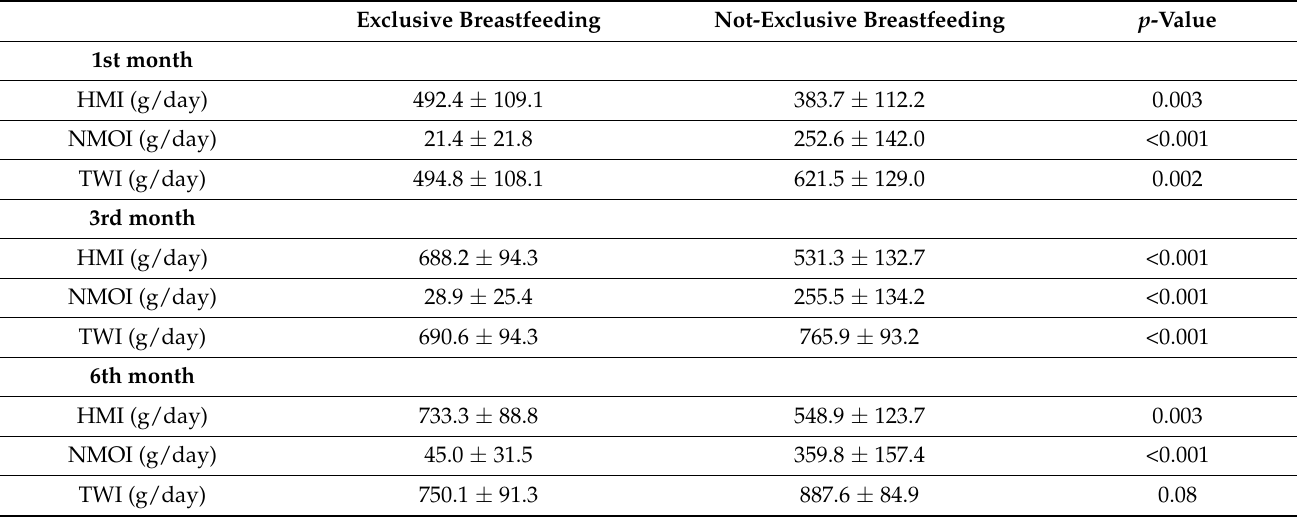
Table 3. Average intake (g/day) of breast milk and water from sources other than breast milk during the 1st, 3rd and the 6th month of the study according to exclusive and not exclusive breastfeeding.